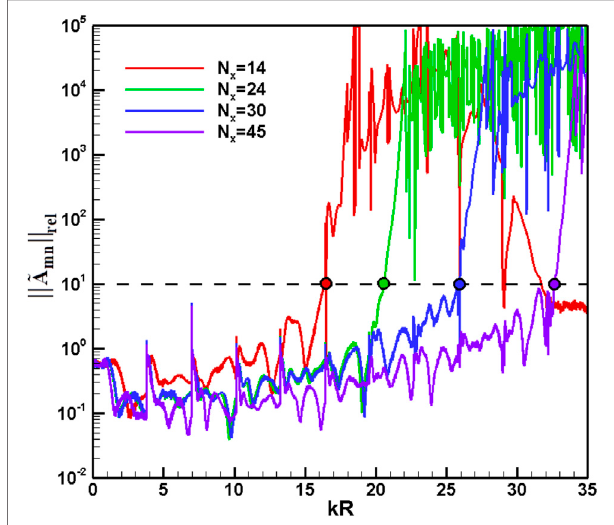
FIGURE 5 | Relative accuracy of the four axial arrays at optimal